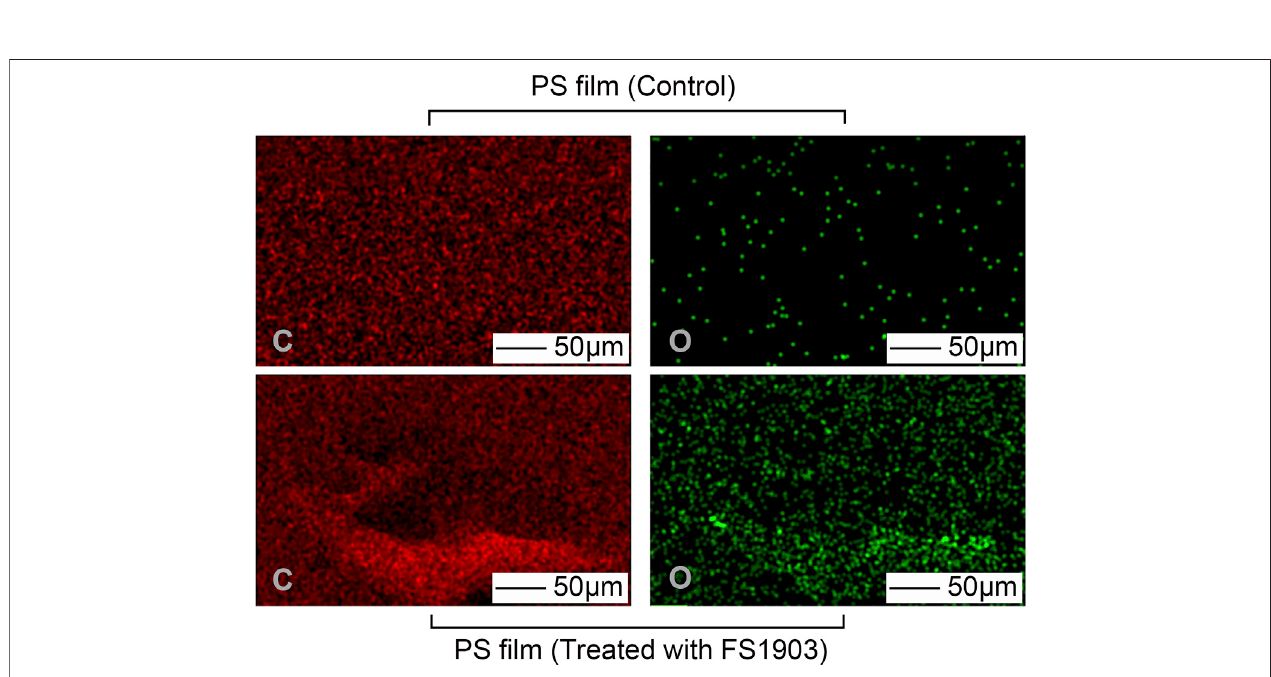
FIGURE 5 | Changes in atomic composition of the PS fi lm surface after treatment with FS 1903. Note: “ C ” represents carbon and “ O ” represents oxygen.